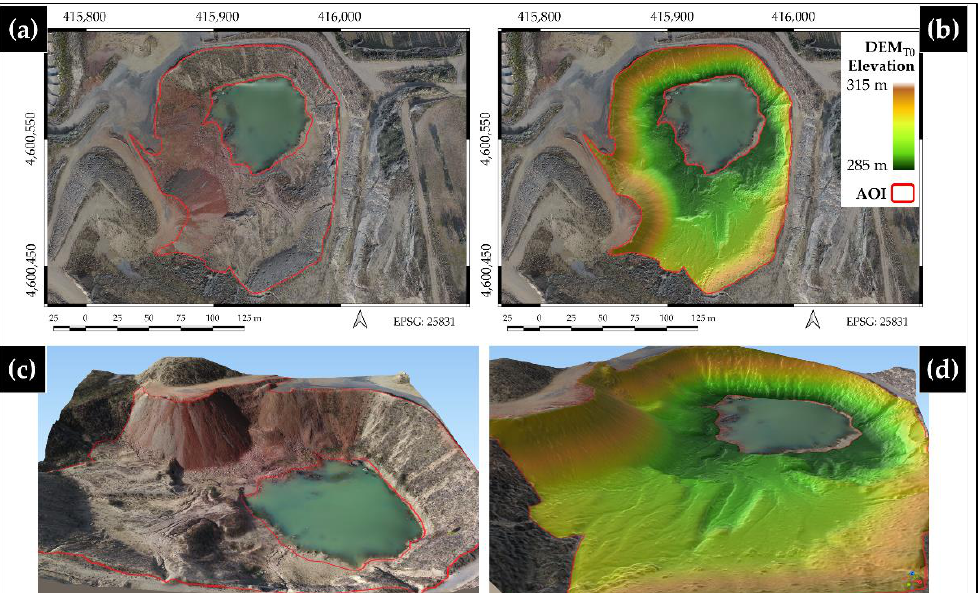
Figure 4. ( a ) Orthoimage resulting from the UAS flight and delimitation of the Area of Interest (AOI). ( b ) Digital Elevation Model (DEM) resulting from the UAS flight. ( c ) Detail of the 3D representation of the orthoimage in the AOI. ( d ) 3D representation of the DEM and the orthoimage in the AOI, where the eroded terrain can be clearly seen. Source: Drone imagery acquired